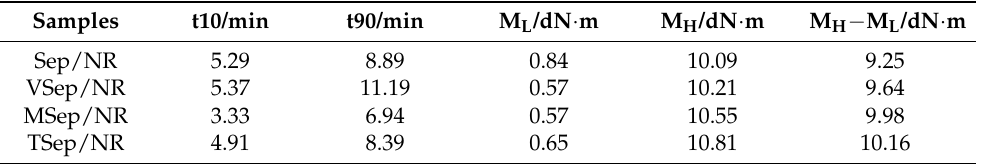
Table 4. The curing characteristics of sepiolite/NR